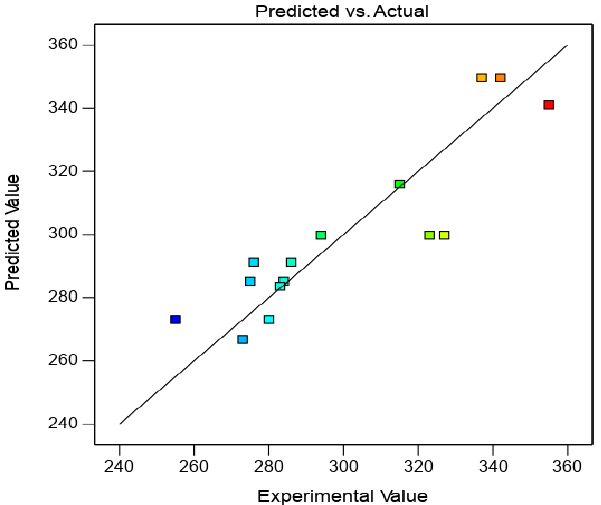
Figure 7. Comparison of model-predicted values versus actual experiment values for cut width. The final equation obtained for the prediction of cut-width (L) is represented as Equation (9):